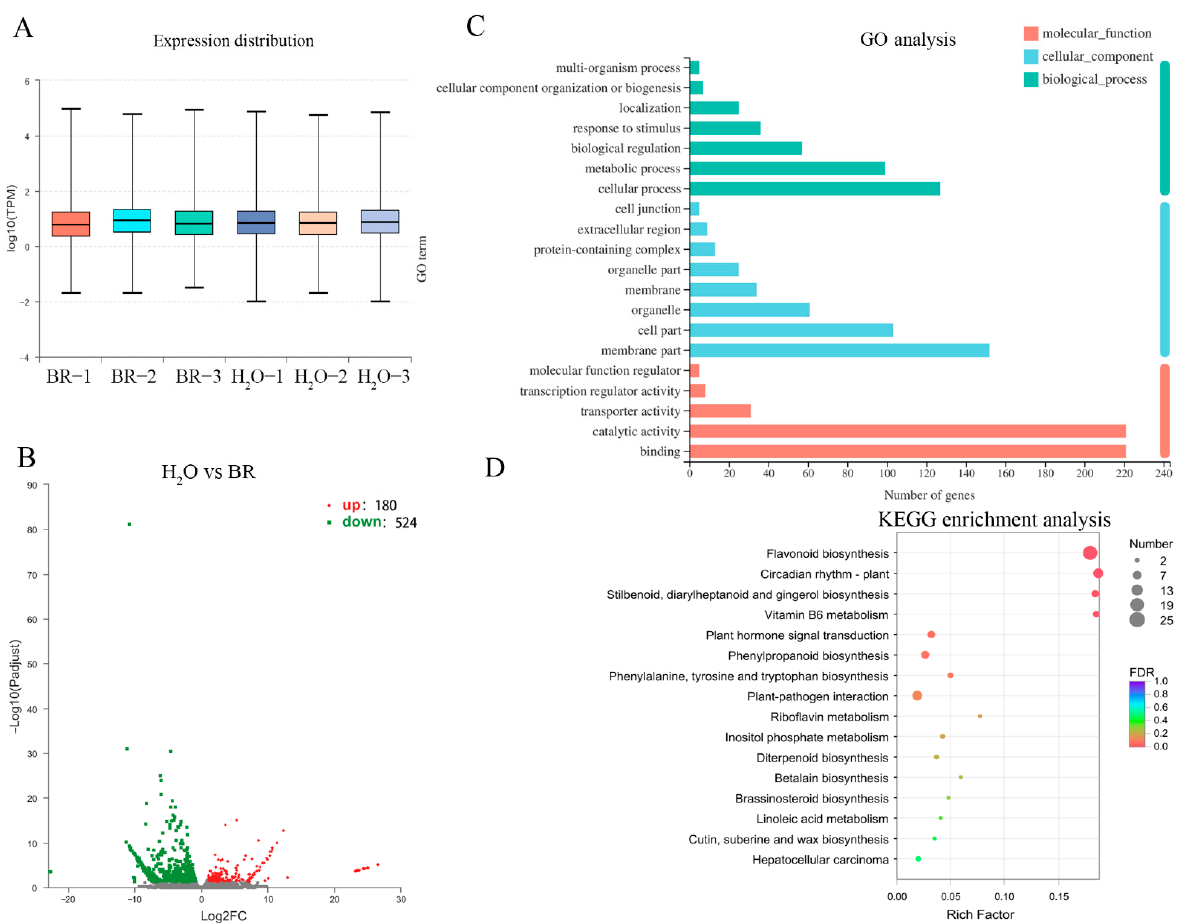
Figure 4. Identification of relative differentially expressed genes (DEGs) after 1 mg · L − 1 BR treatment and enrichment analysis of unigenes. ( A ) Unigene expression abundance of each sample. ( B ) Identification of DEGs between 1 mg · L − 1 BR and H 2 O treatment. Red and green dots indicate the up- and down-regulated genes, respectively. ( C ) Top 20 of GO enrichment analysis of DEGs for cellular component, biological process and molecular function. ( D ) KEGG enrichment of DEGs. The size of dots represents the gene number, and color of dots represents the FDR